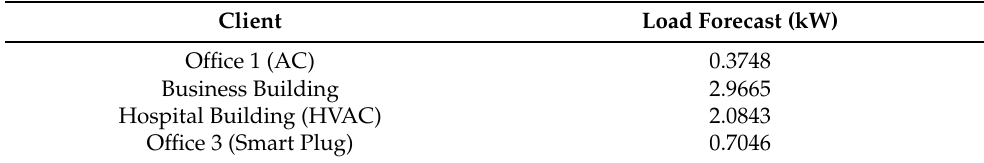
Table 1. Load forecasts received by the